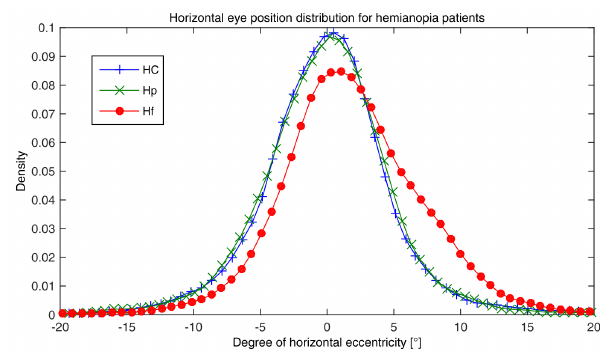
Figure 5 . Horizontal eye distribution of the control group (HC), HVFD patients who passed the driving test (Hp) and HVFD patients who failed (Hf) the driving test. ANOVA results for the gaze parameters and driving